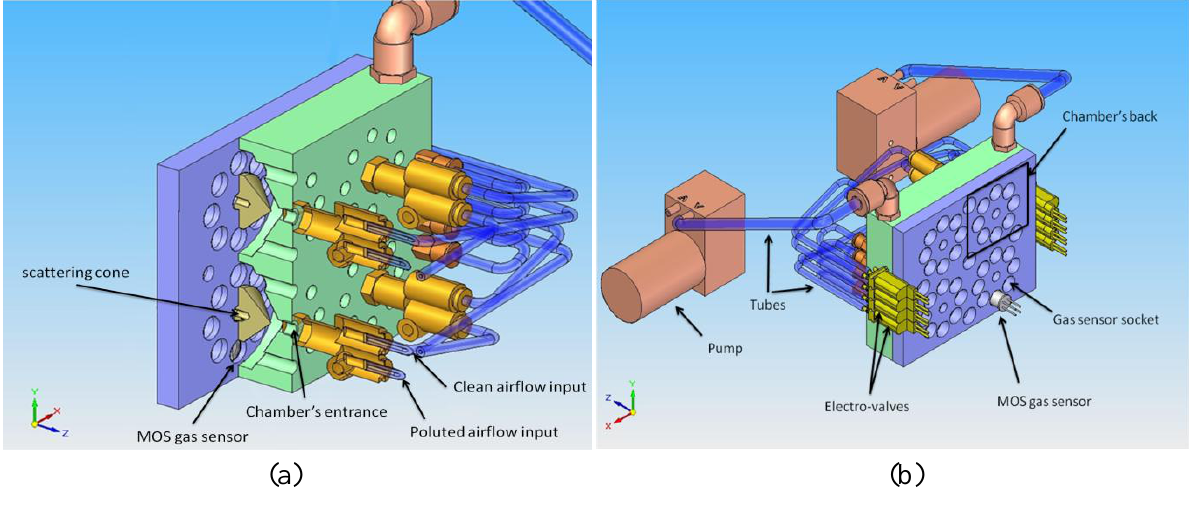
Figure 4. Different views of the 3D model (a) upper view, (b) bottom view, of the pneumatic circuit and the main block containing four chambers which can accommodate up to 8 MOS sensors